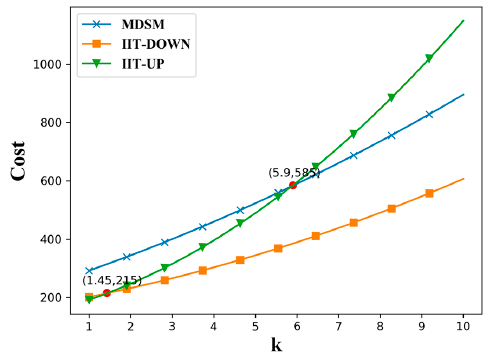
Figure 9. Impact of 𝑘 on deployment costs.